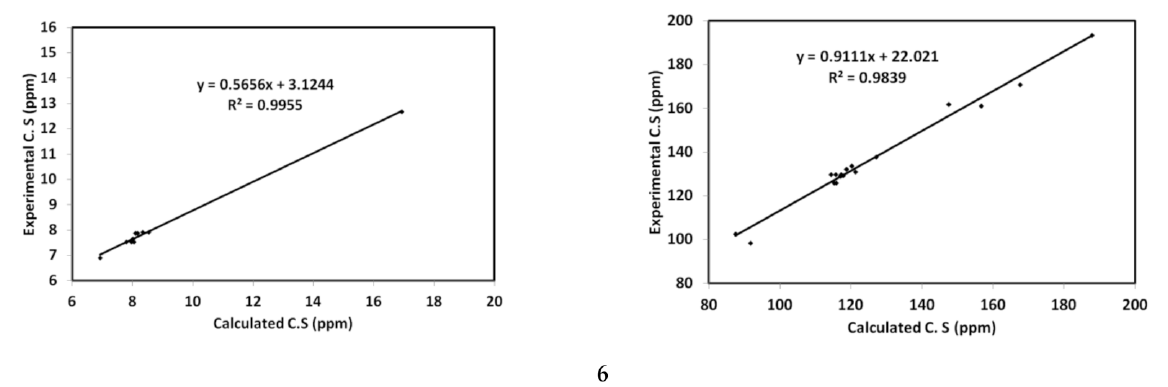
Figure 16. Correlations between the experimental and calculated chemical shifts for the studied compounds. 1 – 6 are described in Figure